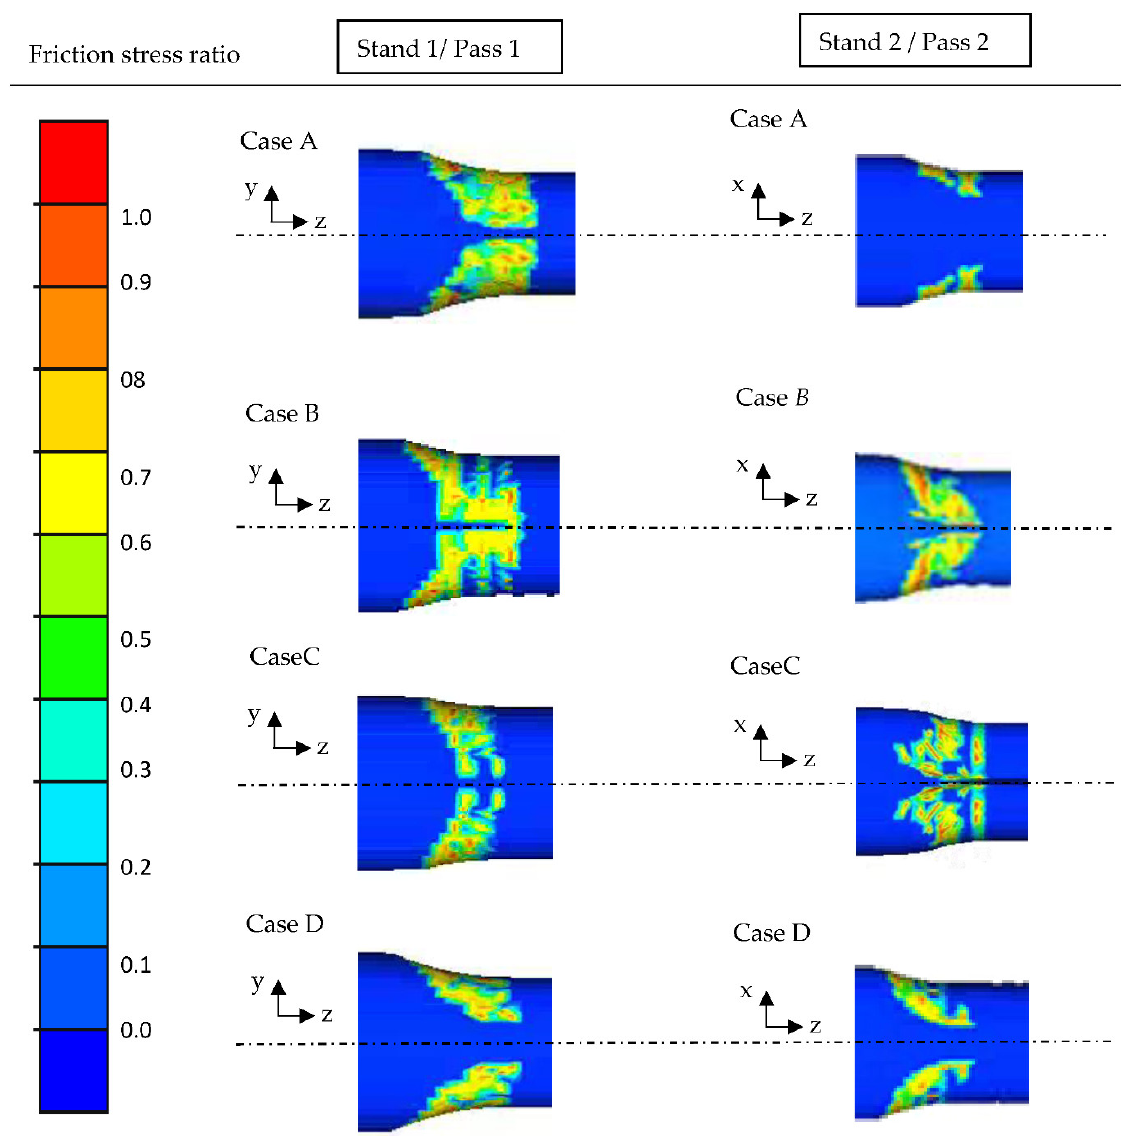
Figure 9. The friction stress ratio and the contact pressure distributions at the cross sections along the vertical direction and the rolling direction.